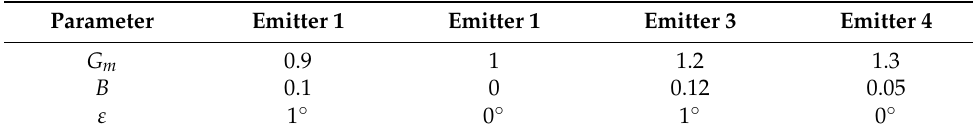
Table 2. QPSK-modulated radiation-source parameter